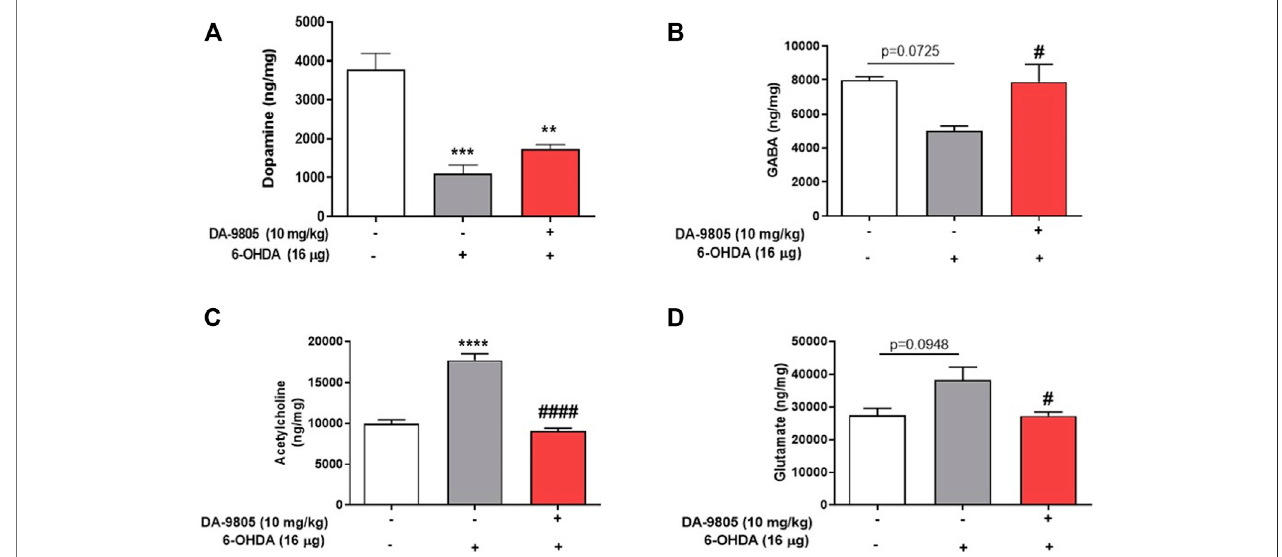
FIGURE 2 | Effect of DA-9805 on levels of striatal neurotransmitters altered by 6-hydroxydopamine (6-OHDA) in mice. Striatal levels of dopamine (DA) (A) , gamma aminobutyric acid (GABA) (B) , glutamate (Glu) (C) and acetylcholine (Ach) (D) . Values are given as the mean ± S.E.M. (A – D) Data were analyzed by One-way ANOVA followedbyposthocBonferroni ’ smultiplecomparisonstest.** p < 0.01,*** p < 0.001and**** p < 0.0001;comparedtotheshamgroup. # p < 0.05and #### p < 0.0001vs. 6-OHDA group. N = 8 in Sham group and N = 12 in 6-OHDA and DA-9805